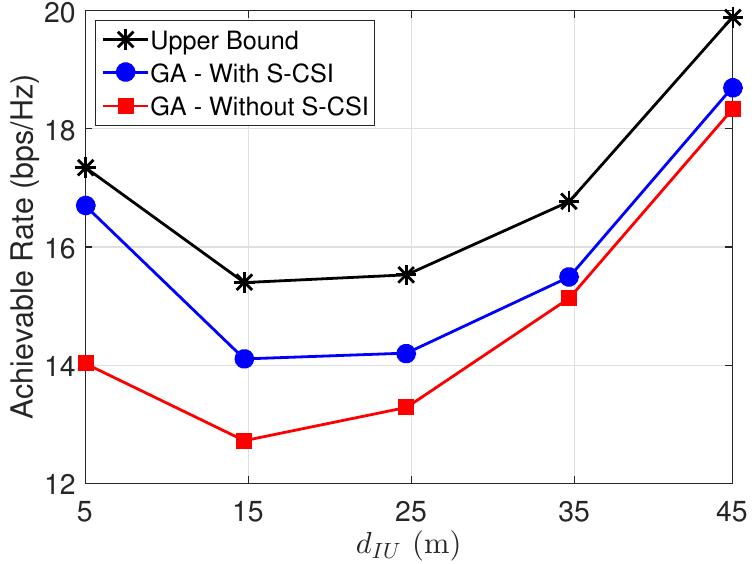
Figure 6. Achievable rate versus BS-UE distance for M =